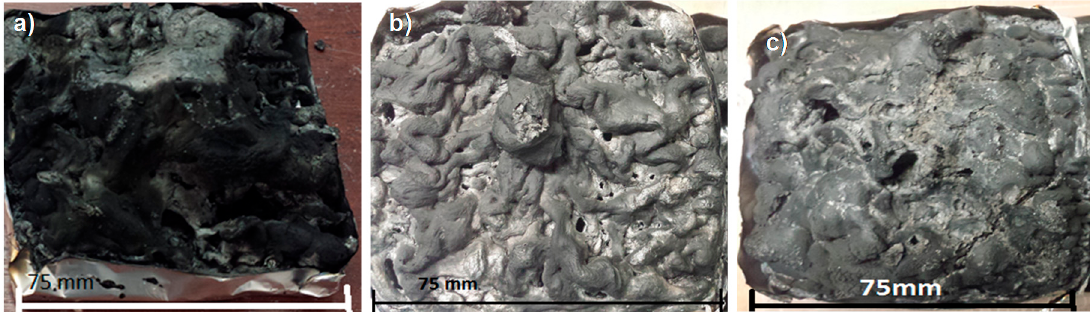
Figure 7. Plots of ( a , c ) heat release rate (HRR), and ( b , d ) mass loss vs. time of uncoated PMMA, PMMA coated with PVPA and ( a , b ) PVPA/1% MgO, ( c , d ) PVPA/5% CaSiO 3.